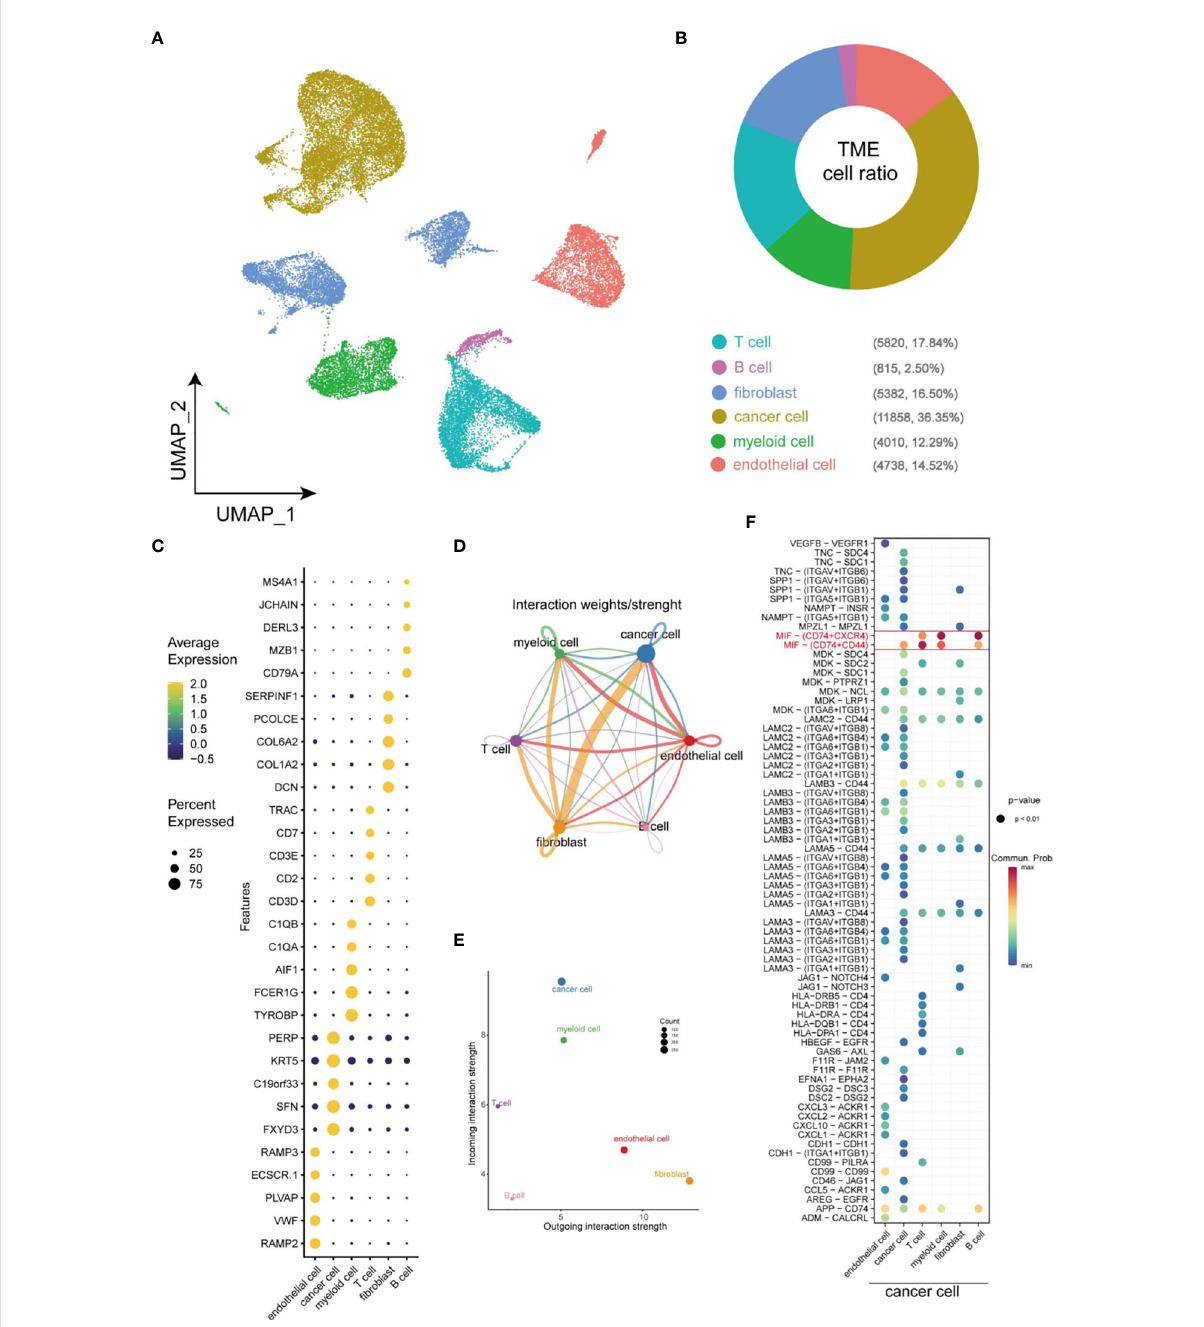
FIGURE 1 Overview of cellular heterogeneity of integrated single-cell expression pro fi ling in HNSCC. (A) UMAP plot of 33623 cells in HNSCC. (B) Pie chart of the proportion of 6 types of cells in HNSCC. (C) Bubble plot of the top fi ve highest expressed genes within 6 types of cells in HNSCC. The size of bubble represents the percentage of gene expression in the relevant cell types. (D) Weights/Strength of cell-cell interaction between different types of cells within HNSCC. (E) Output/input interaction strength of different types of cells within HNSCC. (F) Ligand-Receptor pairs between cancer cells and other cells in